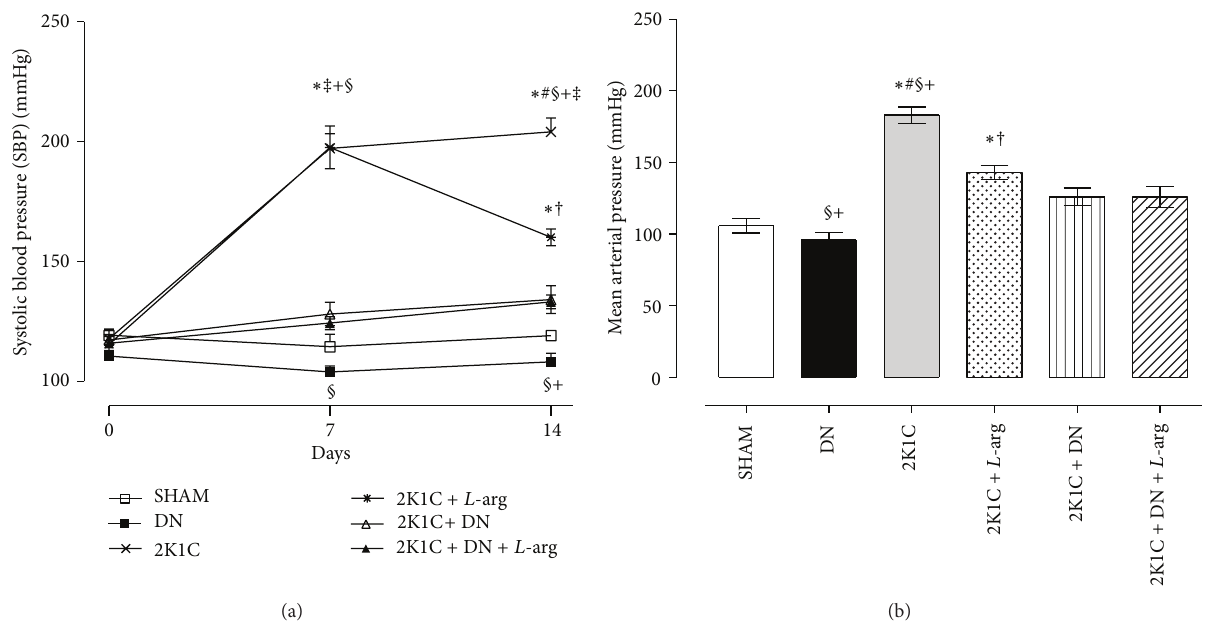
Figure 1: (a) Systolic blood pressure data measured by tail cuff in renovascular hypertensive rats (time 0: baseline before surgery, 7th day after surgery and/or denervation, and 14th day after surgery and/or denervation and L -arginine treatment). (b) Mean arterial pressures at the end of experiment in conscious rats for all experimental groups (SHAM: normotensive control; 2K1C: two-kidney one-clip; 2K1C+ L -arg: two- kidneyone-cliptreatedwith L -arginine;DN:denervatednormotensive;2K1C +DN:denervatedtwo-kidneyone-clip;and2K1C +DN + L -arg: denervated two-kidney one-clip treated with L -arginine). The results are expressed as mean ± SEM. ∗ 𝑃 < 0.05 versus SHAM; † 𝑃 < 0.05 versus 2K1C; ‡ 𝑃 < 0.05 versus DN; # 𝑃 < 0.05 versus 2K1C+ L -arg; § 𝑃 < 0.05 versus 2K1C+DN, and + + 𝑃 < 0.05 versus 2K1C+DN+ L -arg (Tukey